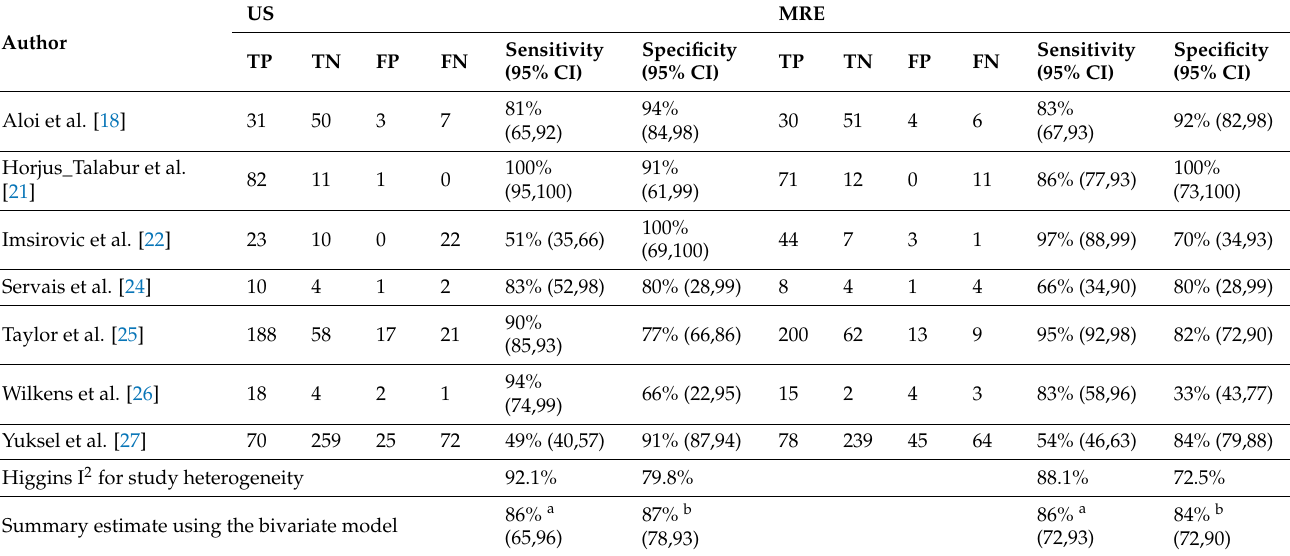
Table 5. Direct comparison of diagnostic performance for active bowel lesions between US and